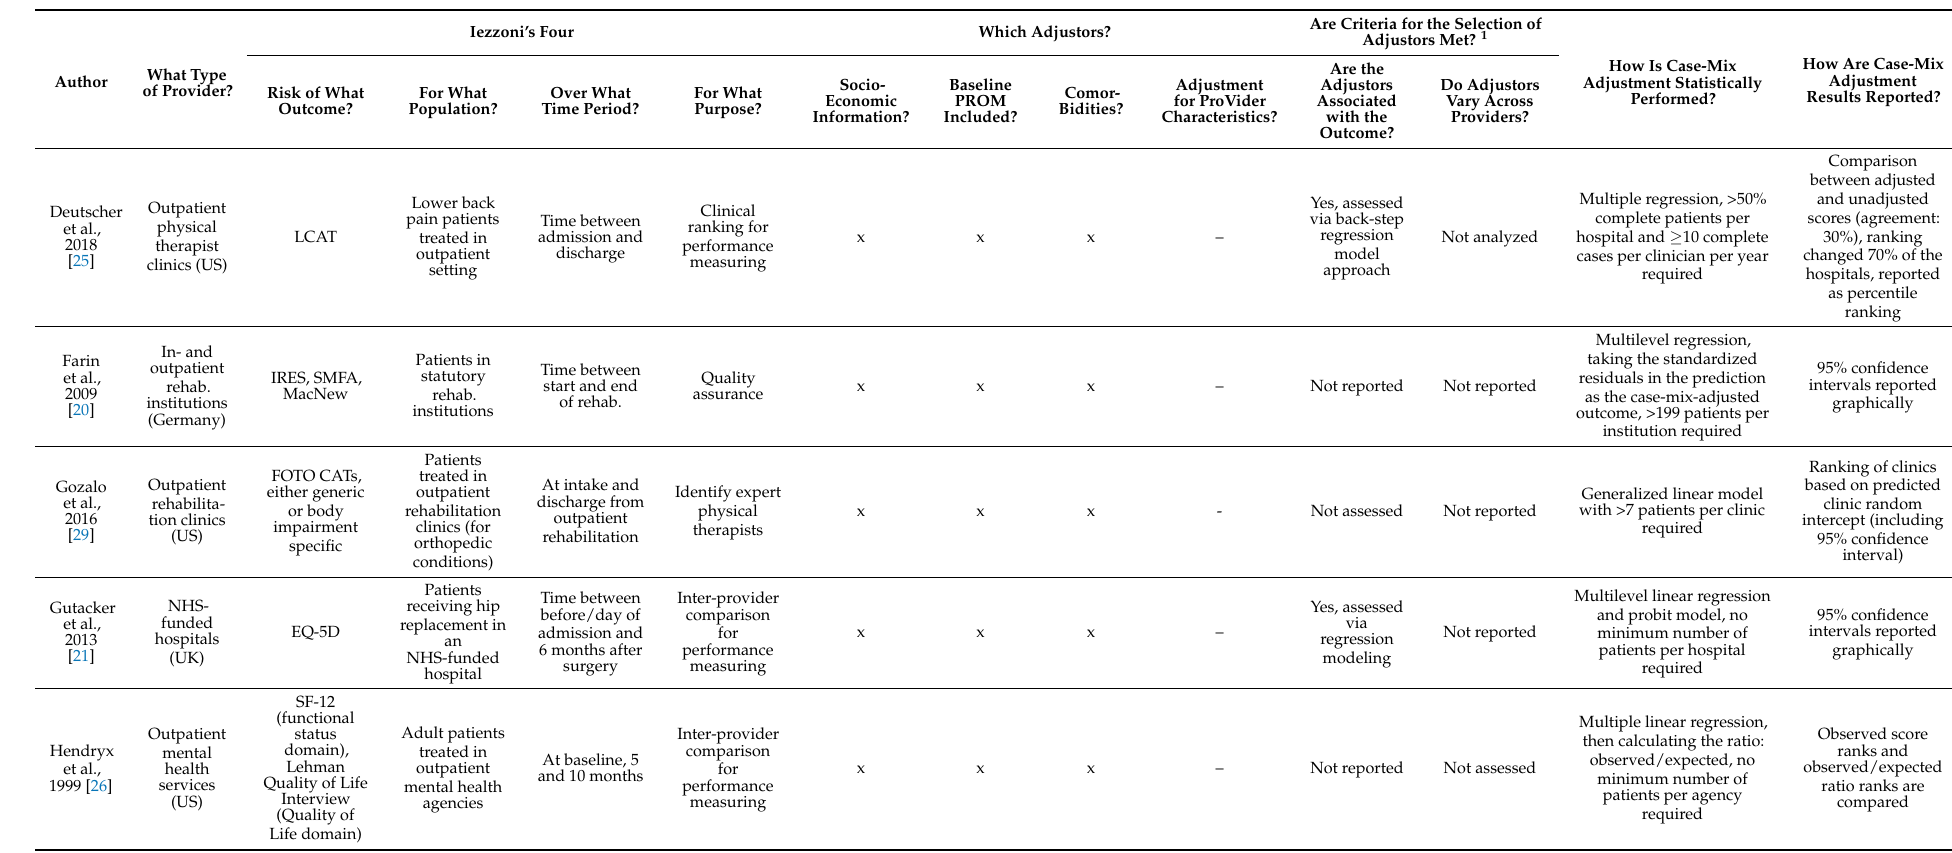
Table 2. Synthesis of case-mix adjustment